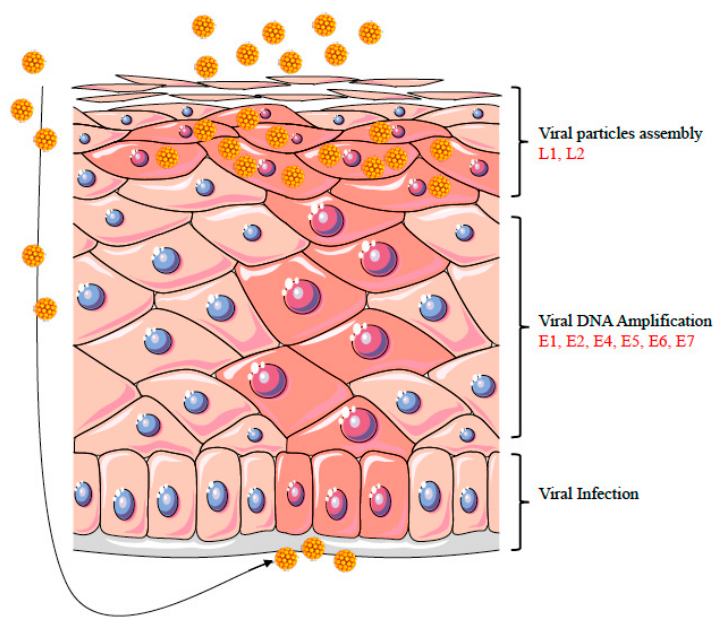
Figure 1. Epithelial differentiation triggers the productive phase of the HPV life cycle. The figure shows a diagram of a stratified epithelium. HPV-infected cells are shown with pink nuclei. HPV infects the basal keratinocytes of the stratified epithelium through a microwound (as shown by the black arrow on the left). Epithelial differentiation triggers the amplification phase of HPV life cycle, followed by late gene expression and virion assembly. The increased HPV replication is shown in the diagram by more numerous and larger pink circles, which indicate an increase of both viral replication centers and DNA damage